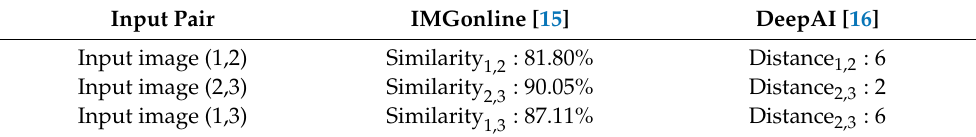
Table 11. Similarity score calculation on the same ukiyo-e print digitized at the different institutions. Model